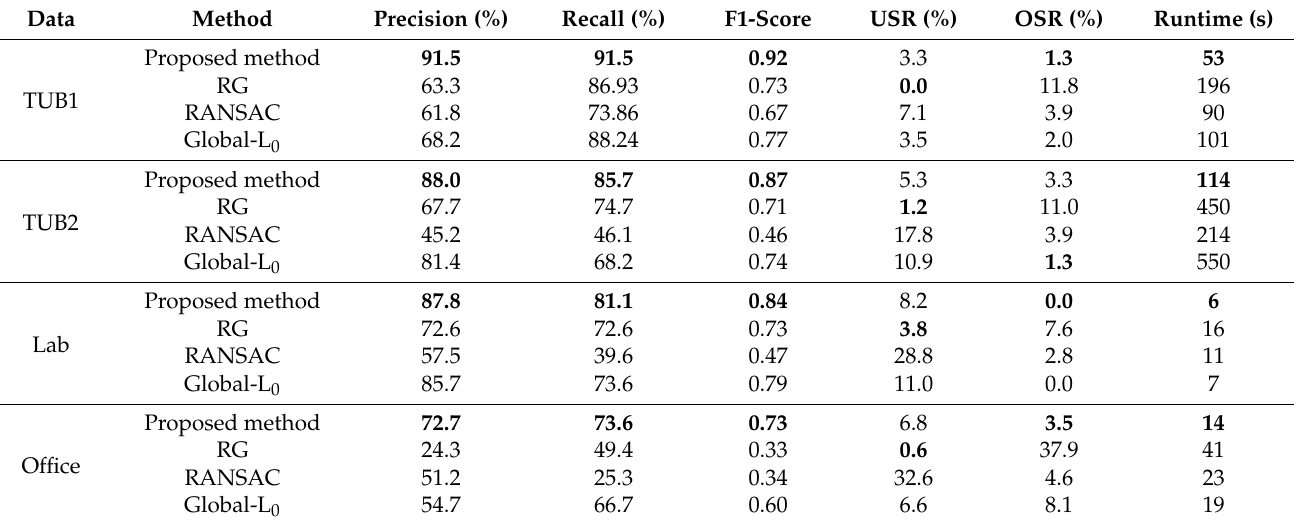
Table 3. Comparison of the various algorithm performances in the four considered